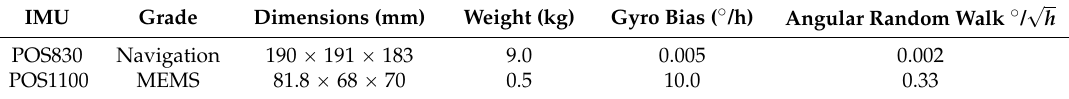
Table 1. Parameters of the IMU sensors used in the data processing.